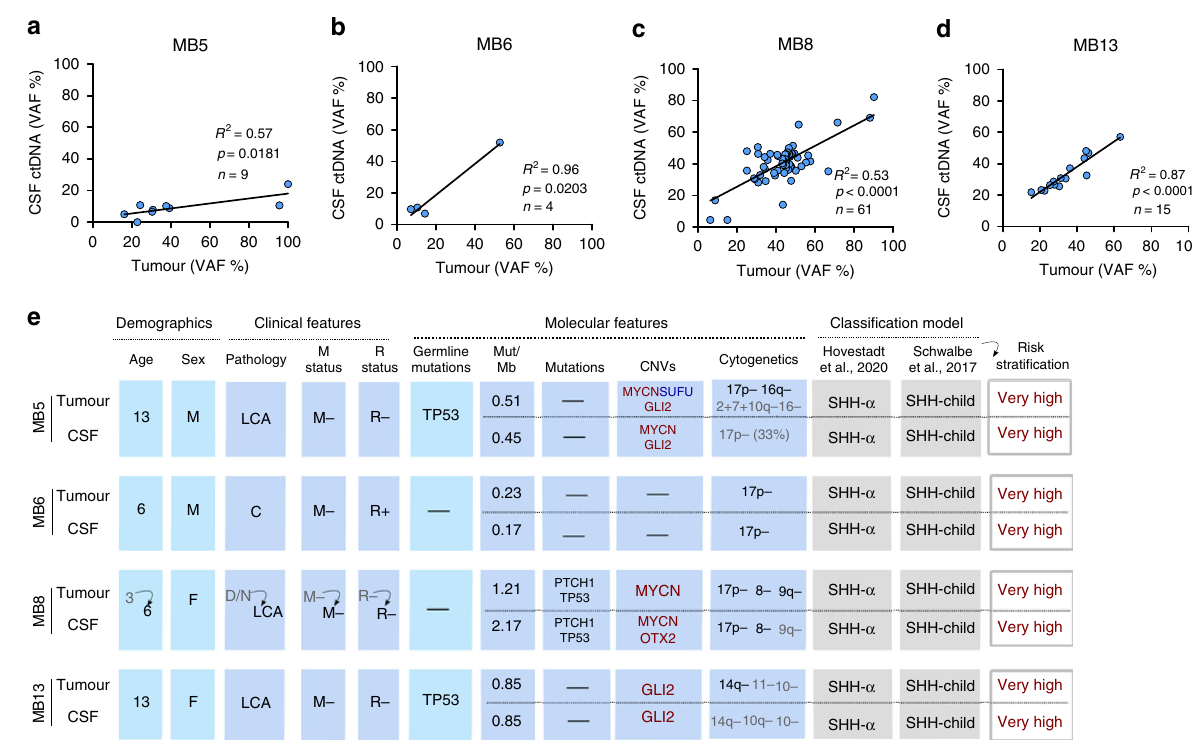
Fig. 3 WES of CSF ctDNA reveals the genomic alterations of the tumour and identi fi es MB-subgroup. a – d Correlation of CSF ctDNA VAF with tumour VAF for each mutation identi fi ed in the tumour sample (VAF > 5%). Linear regression and Goodness-of- fi t R 2 indicated in each fi gure. n, represents the number of mutations detected in the primary tumour sample with VAF > 5%. e Clinicopathological characteristics and molecular alterations based on tumour and CSF ctDNA WES analysis. MB-subgroup classi fi cation and risk strati fi cation (based on Schwalbe et al., 2017 5-year PFS). Frequency of somatic mutations in coding regions per Mb (Mut/Mb) based on a 17.7 Mb (MB5, MB6, MB13), 50.4 Mb (MB8-Tumour) and 51.6 Mb (MB8-CSF) WES panel. CNV: deletion (log 2 value < − 1, blue), ampli fi cation (log 2 value > 1, red). For the cytogenetic analysis, the threshold for the percentage of arm-level or chromosome gain/loss was determined by the mean and the percentiles of the events from the cohort of 13 MB as indicated in Fig. 1: greater than 75% percentile (>65.5%) in black and greater than the mean (>44.5%) in grey. The de fi nition of the symbols and acronyms are in accordance with Fig. 1 and